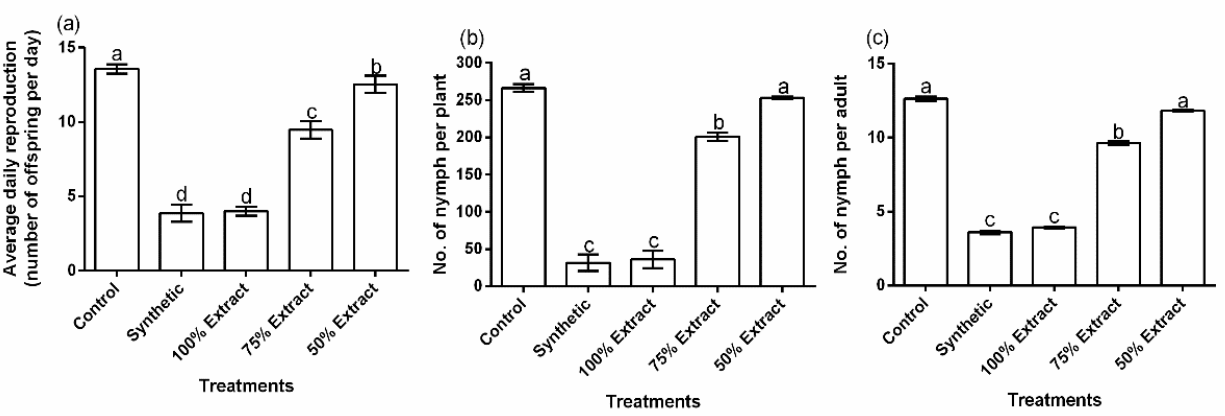
Figure 2. Effect of potato leaf extract on ( a ) average daily reproduction, ( b ) the number of nymphs per plant, and ( c ) the number of nymphs per adult. Data represent the mean ± standard deviation of three replicates. Lowercase letters indicate means that are significantly different according to the LSD test ( p < 0.05). Note: “differing Y-axis scales”, synthetic pesticide (recommended rate of Beta cypermethrin).